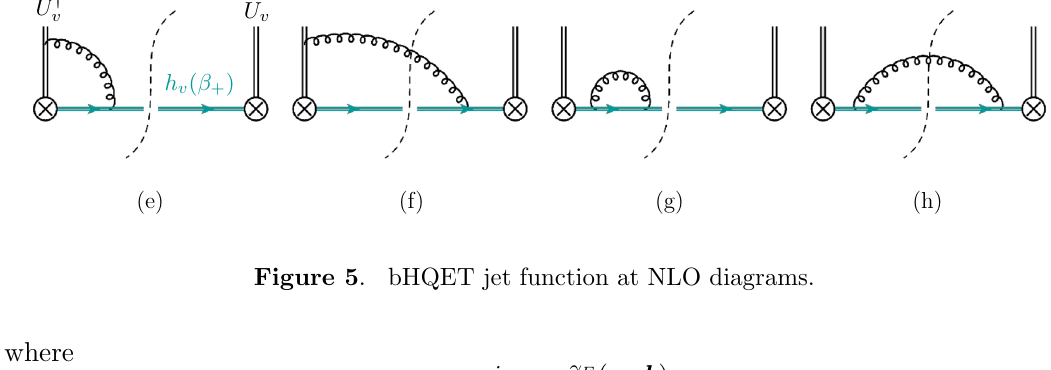
Figure 5 . bHQET jet function at NLO